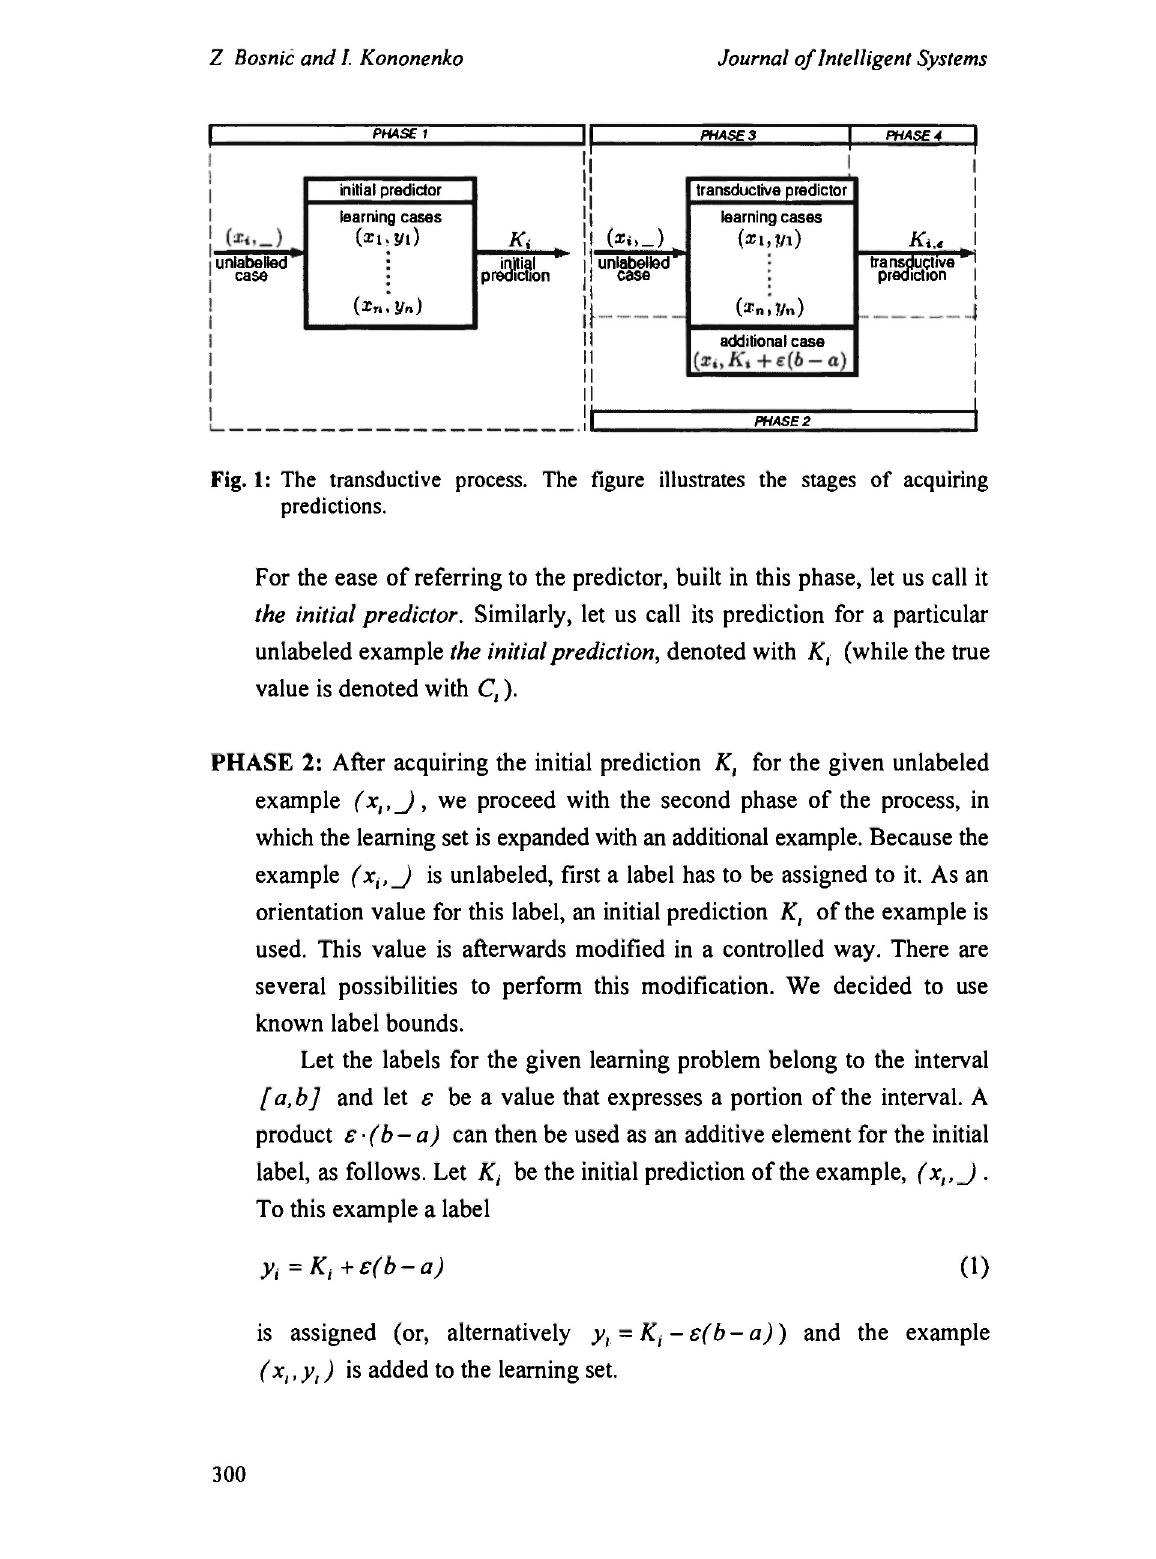
Fig. 1: The transductive process. The figure illustrates the stages of acquiring